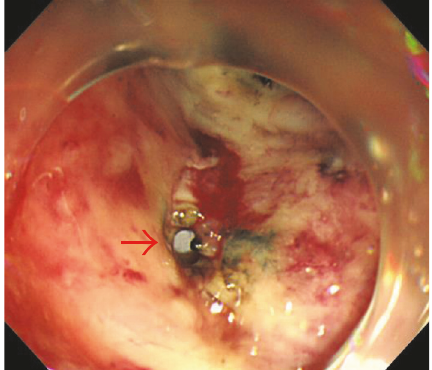
Figure 6: Delayed perforation occurred the day after ESD. Duration of cautery needed for hemostasis in this perforated points was a total of